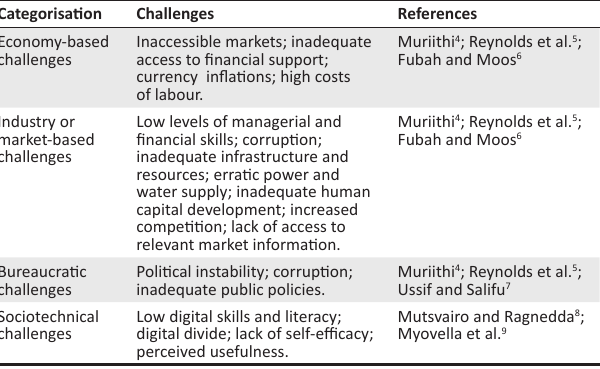
TABLE 1: Challenges affecting small and medium enterprises in the sub- Saharan